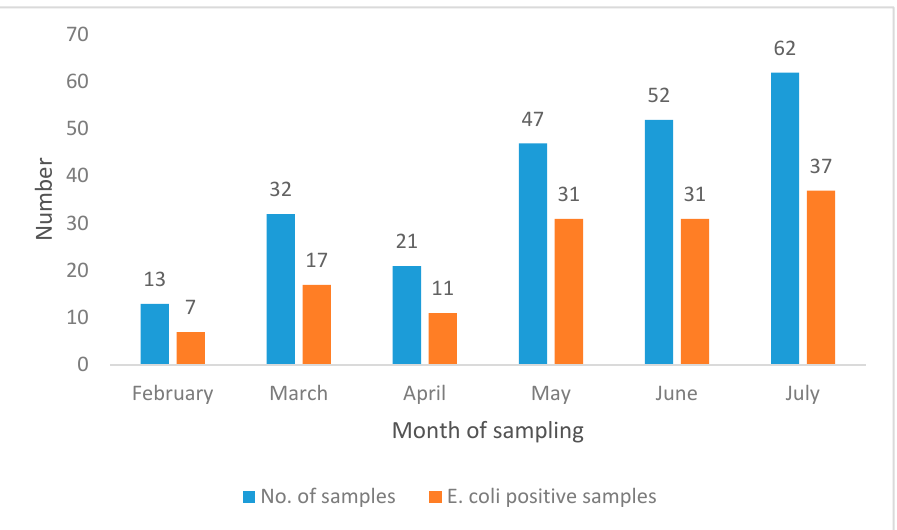
Figure 1. Month-wise distribution of E. coli isolated in broiler liver samples.